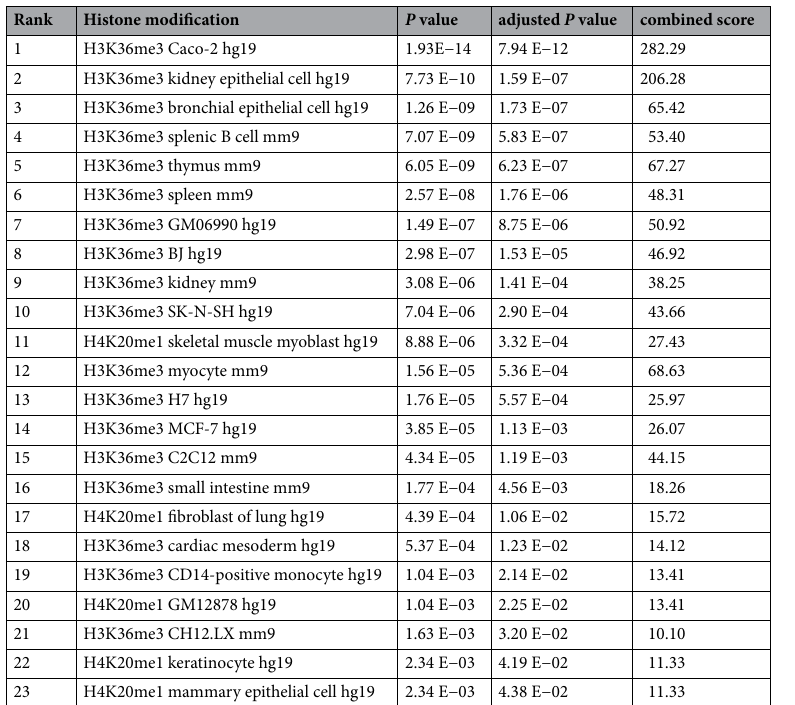
Figure 3. Bar graph of TRRUST Transcription Factors 2019. The graph visualizes the top ten enriched transcription factors of the genes selected by PCAUFE. The bars are colored and sorted according to their P -values.